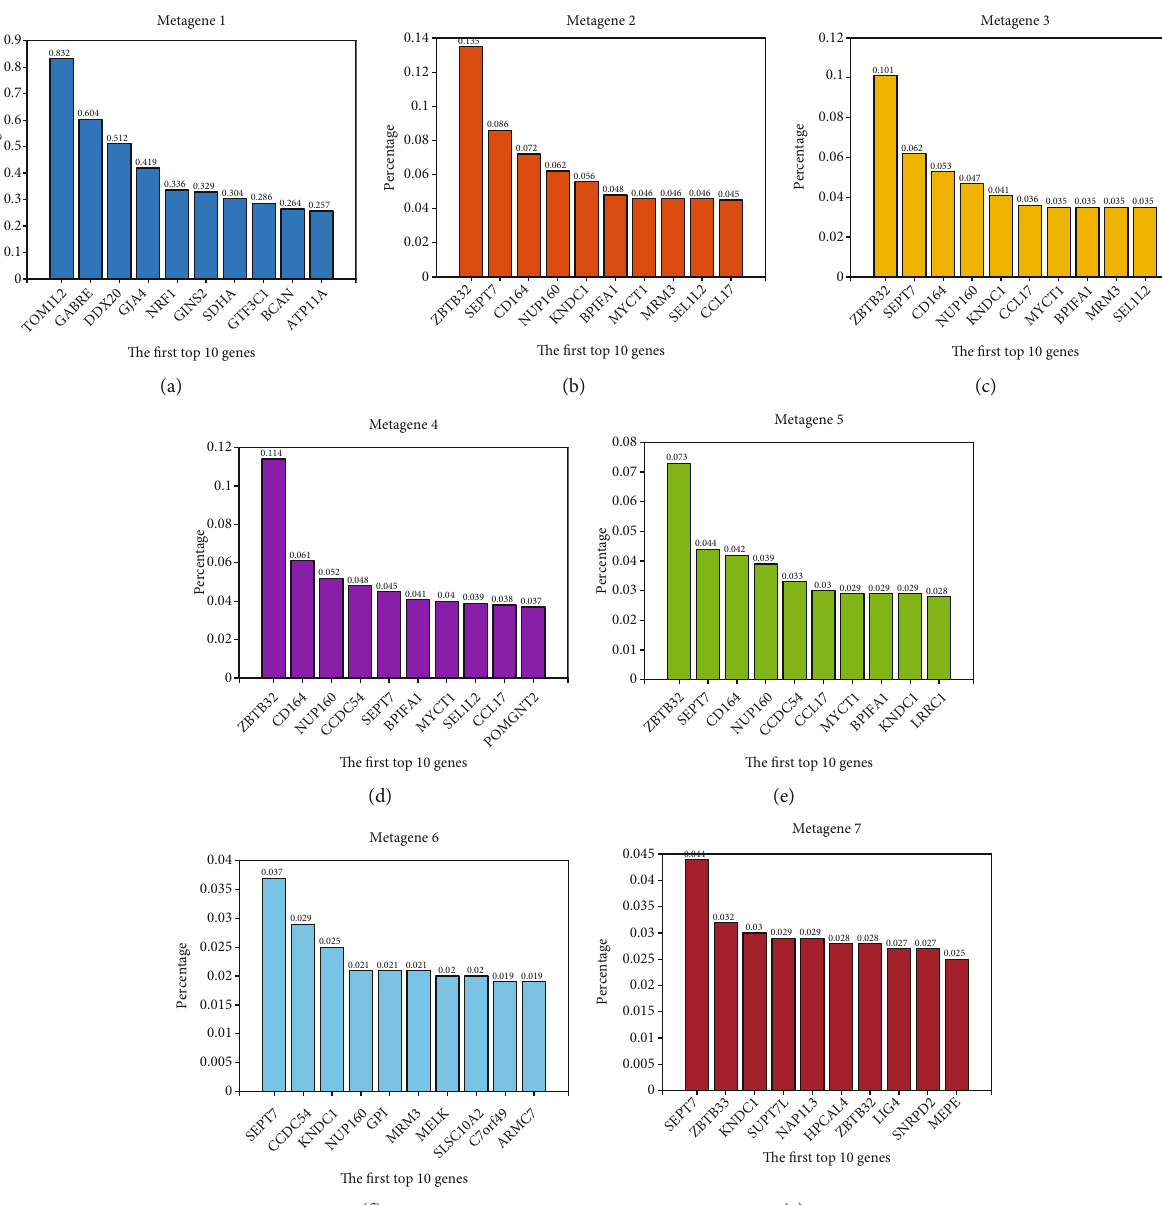
Figure 12: Composition of the seven metagenes (provided by CDSNMF) of MM based on the fi rst top 10 original